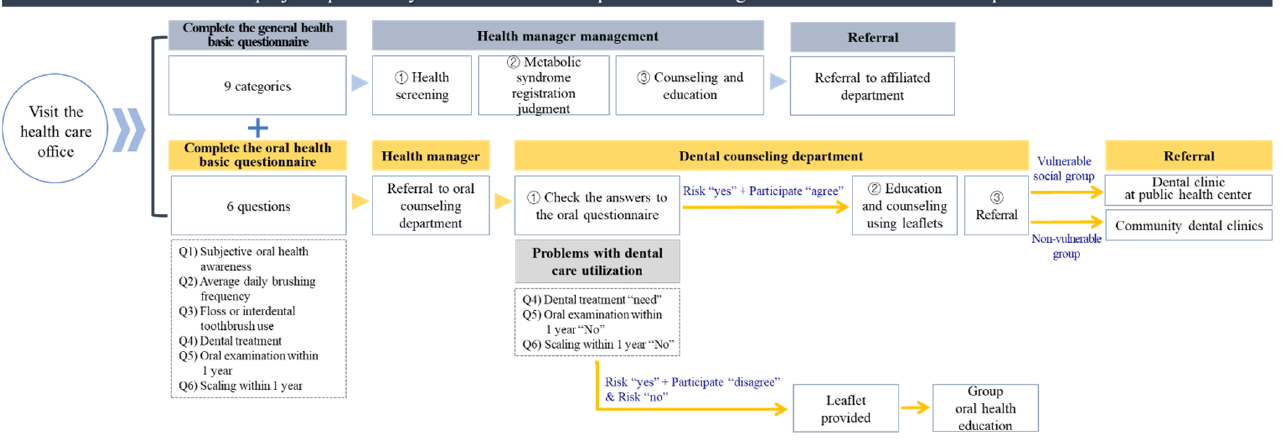
Figure 1. Oral health care and NCD prevention management project system flow.